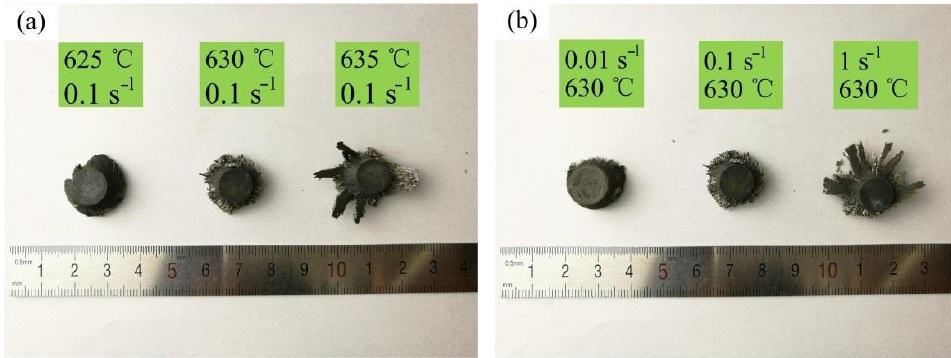
Figure 10. Figure 10. Macroscopic photo of samples after the SSIC at different, ( a ) deformation temperatures, and ( b ) strain rates.